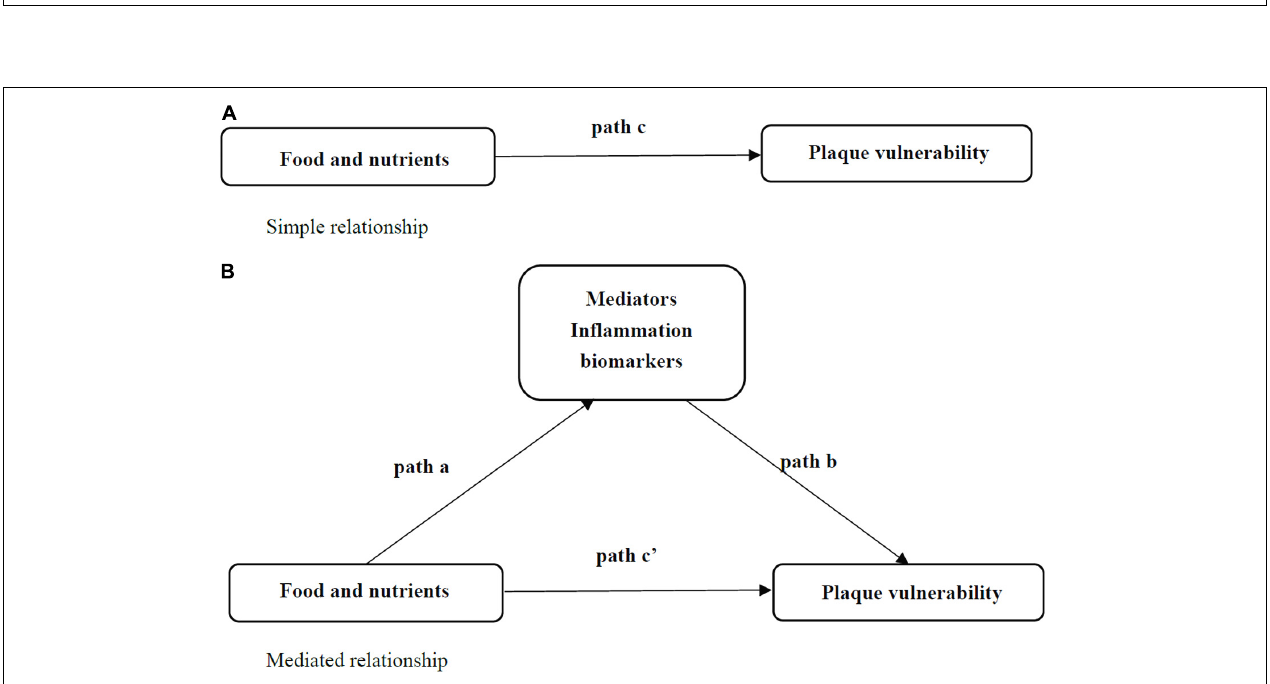
FIGURE 3 | Simple relationship and Mediated relationship. Non-Mediated pathways (A) and Mediated pathways (B) between food and nutrients and plaque vulnerability. Path c ’ represents the direct effect of food and nutrients on plaque vulnerability with the mediator included in the model. The indirect effect is the product of path a and path b (path a * b ). Each mediator was considered in a separate statistical model.